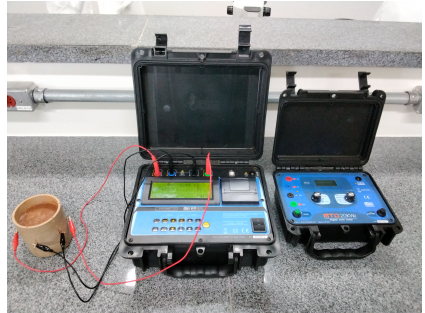
ω . Figure 8. Instruments used to map R m × ω . ×